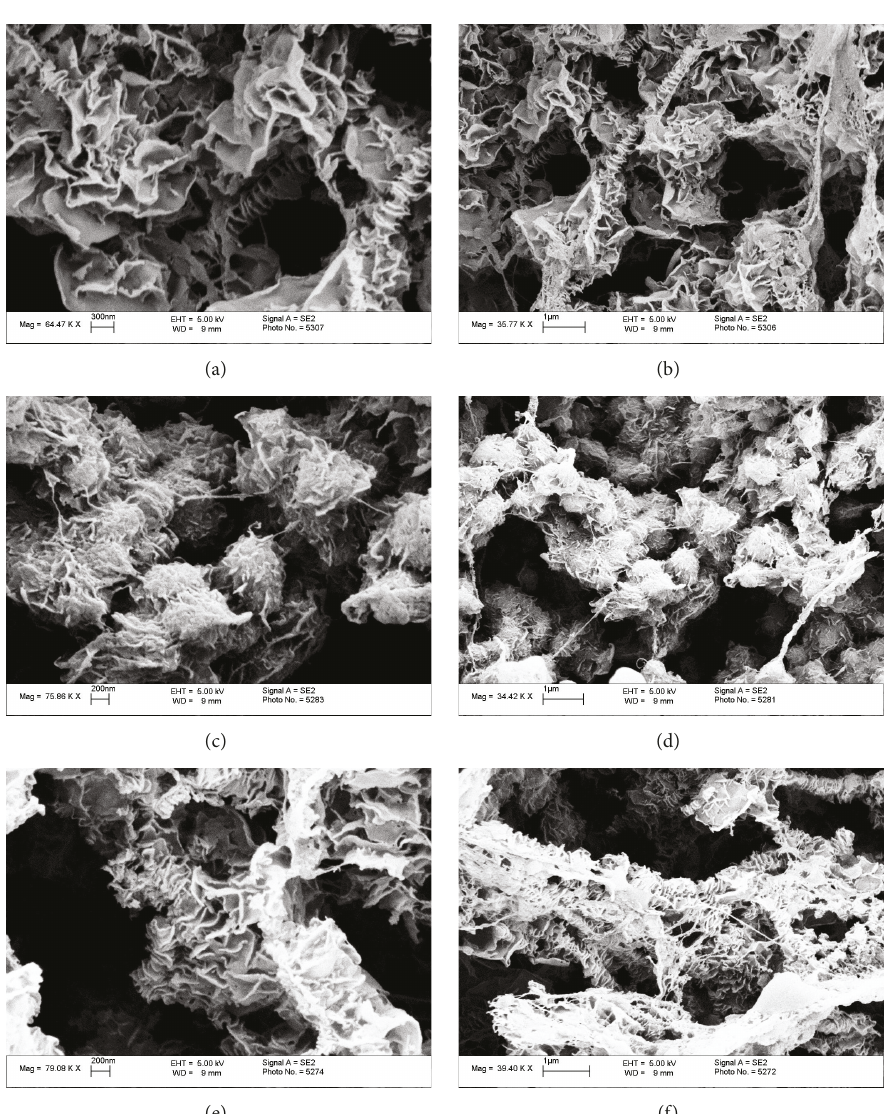
Figure 6: SEM images of nascent UHMWPEs obtained from polymerizations run in pure toluene (a, b), pure heptane (c, d), and 50/50 v/v mixture (e,